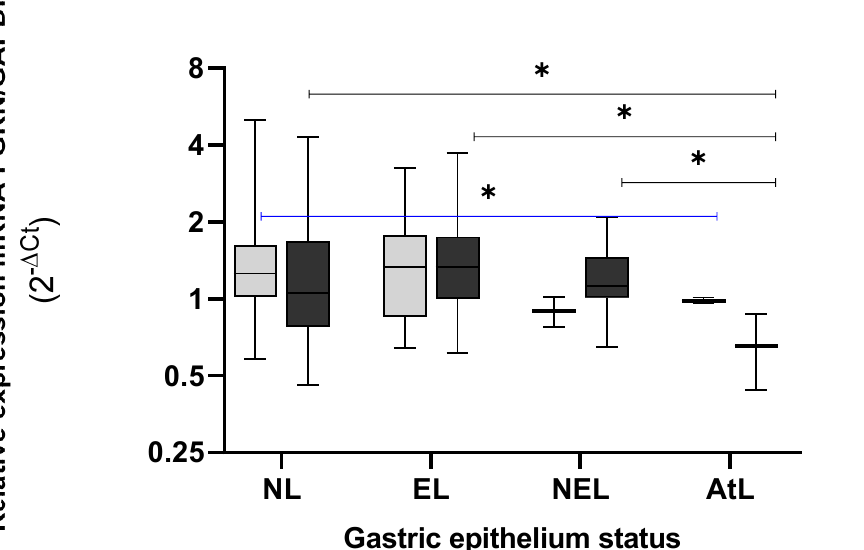
Figure 3. Expression levels of GRN mRNA in gastric tissue with and without lesions from individuals infected ( n = 75) and non-infected with H. pylori ( n = 75). NL = non lesions, EL = erosive lesion, NEL= non-erosive lesion, AtL= atrophic lesion. The PGRN expression values were calculated by formula 2 − ∆ Ct , where ∆ Ct = Ct of GRN − Ct of GAPDH . The status of the gastric tissue was assigned according to the endoscopic observation report. The Kruskal–Wallis and Mann–Whitney tests were used for analysis in or between the groups. Statistical significance was established at < 0.05.